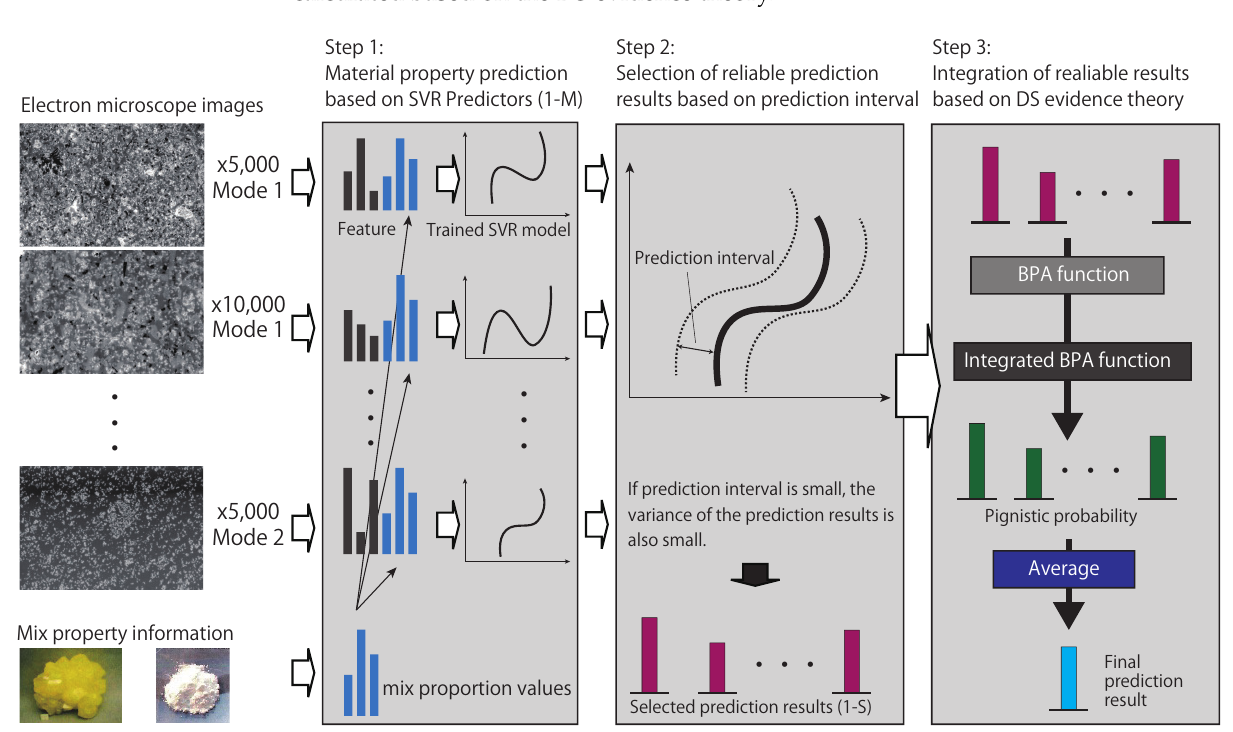
Figure 2. Overview of the proposed method. The proposed method selects S ( < M ) reliable prediction results from M support-vector-regression (SVR)-based prediction results based on the prediction interval and integrates the reliable results based on the Dempster–Shafer (DS) evidence